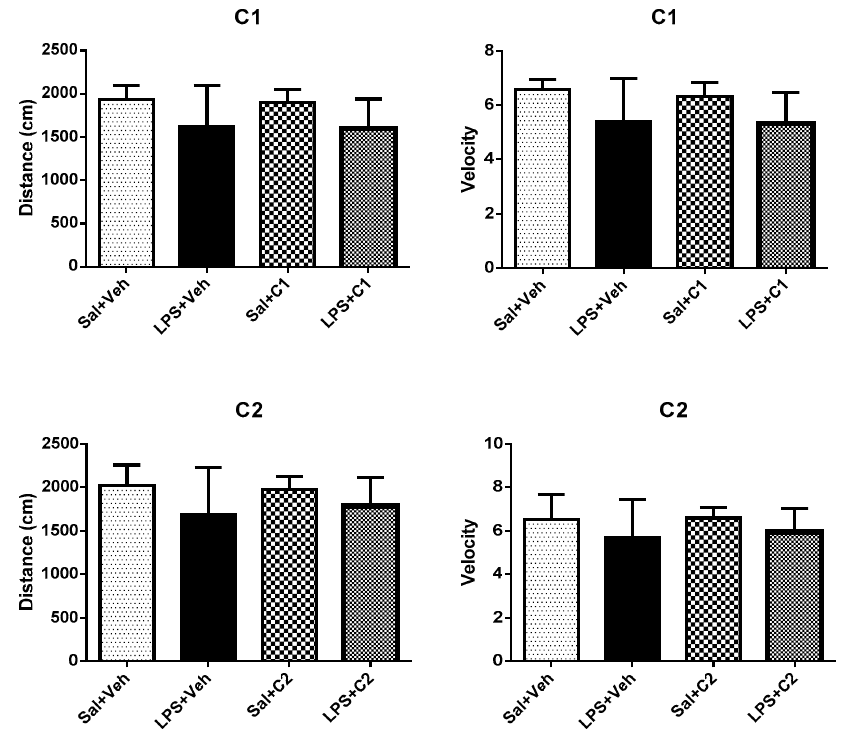
Figure 13. Effects of treatment in distance and velocity performed by rats in Open Field. Saline (sal), Vehicle (veh, vehicle used for the ligand dilution).